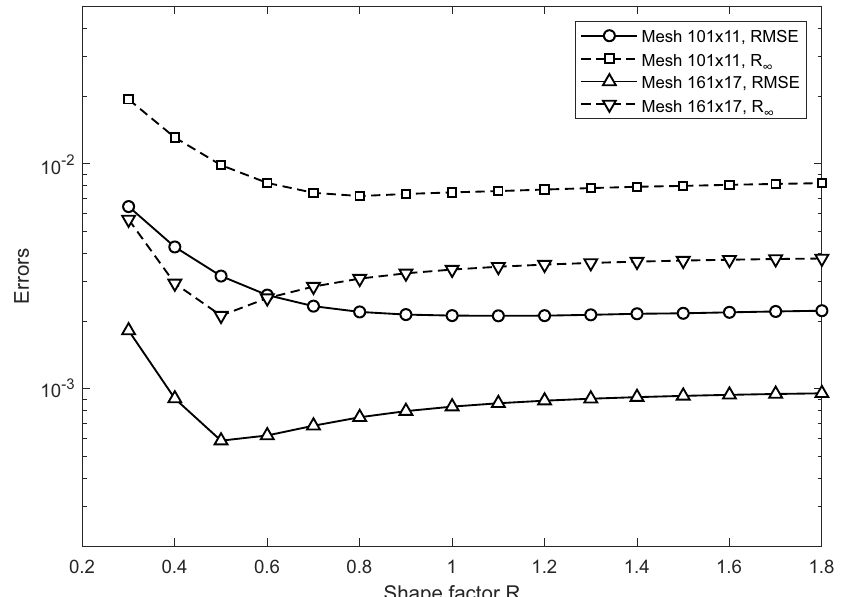
Figure 13. Example No. 3—RMSE and R ∞ as functions of the shape factor R .